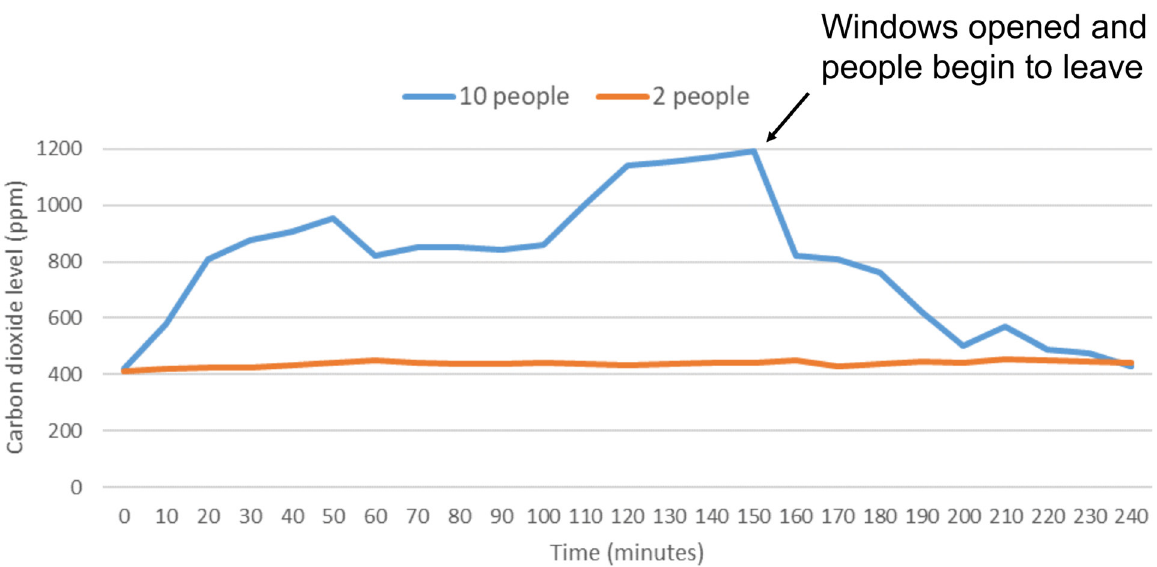
Figure 1. Family room. Carbon dioxide levels in parts per million (ppm) in a family room (volume, 50.7 m 3 ) open to other areas in the house with either 2 or 10 people present. The windows were closed except as indicated by the arrow when 10 people were present. Peak levels of carbon dioxide above 800 parts per million (ppm) were considered an indicator of suboptimal ventilation for the number of occupants